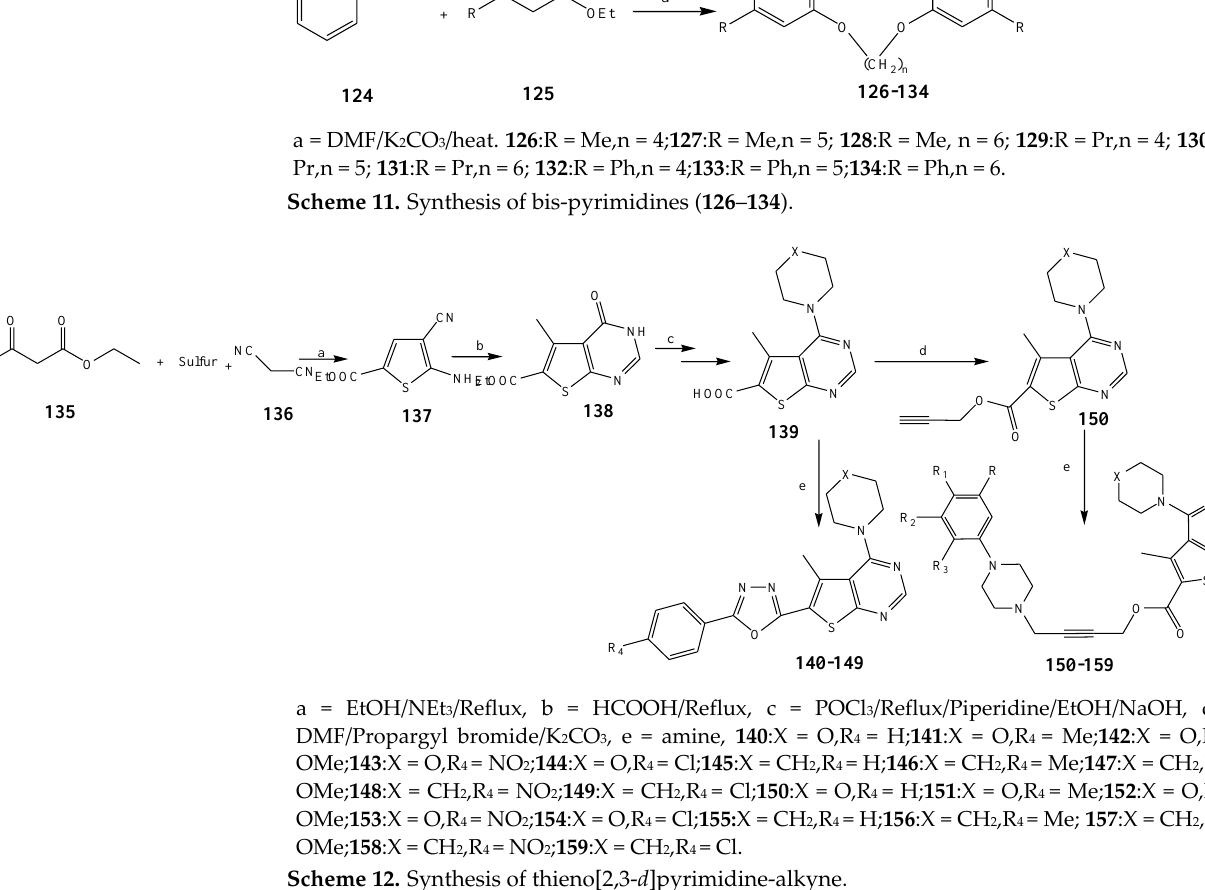
Scheme 12. Synthesis of thieno[2,3- d ]pyrimidine-alkyne.